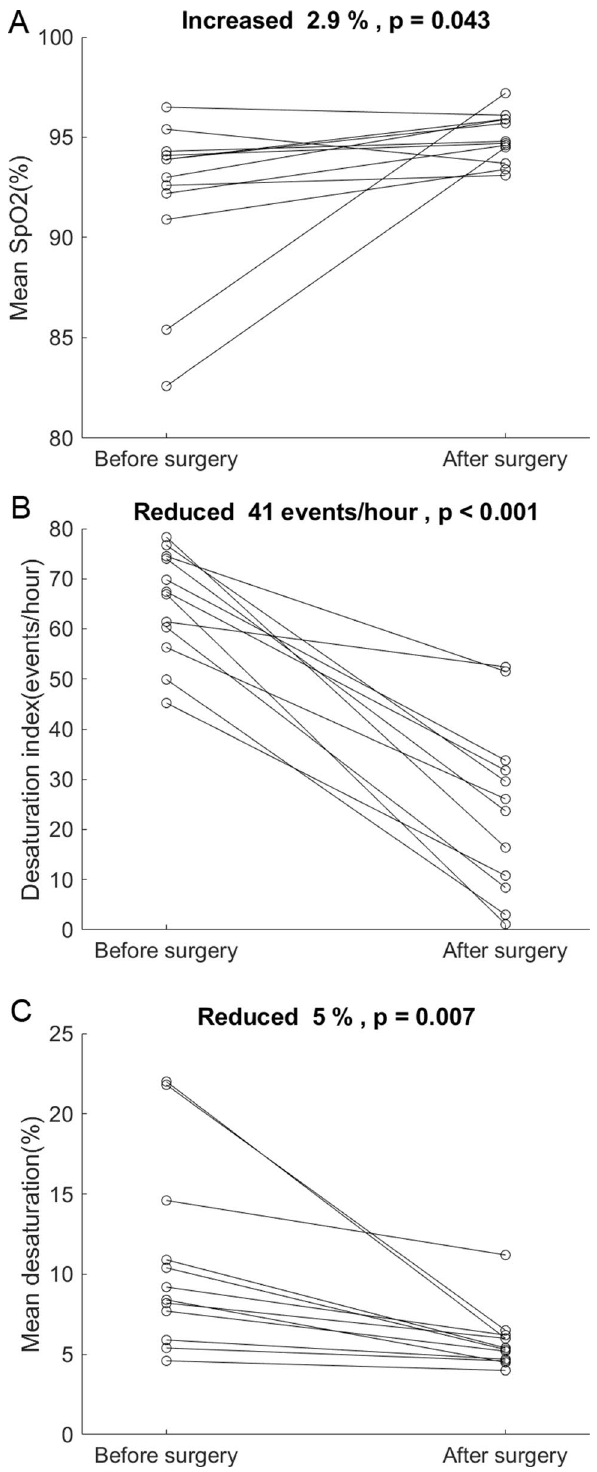
Figure 5. ( A ) Individual change of mean oxyhemoglobin saturation of pulse oximetry (SpO2) after the surgery. It reveals a ceiling effect. ( B ) Individual change of desaturation index after the surgery. The surgery reduced the mean desaturation index by 41 events/h ( p < 0001). ( C ) Individual change of mean desaturation after the